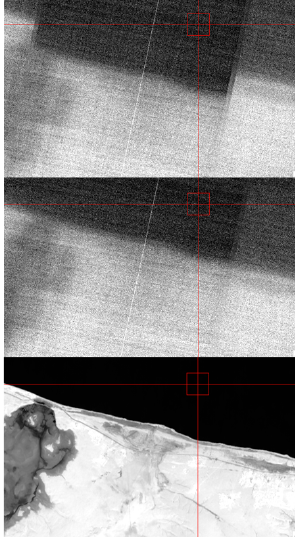
Figure 17. Top : Cirrus band image of the north African coast where there should be no signal from the ground in this atmosphere. Middle : Cirrus band geometrically processed as if it were the SWIR 1 band. Bottom : SWIR 1 image of the same